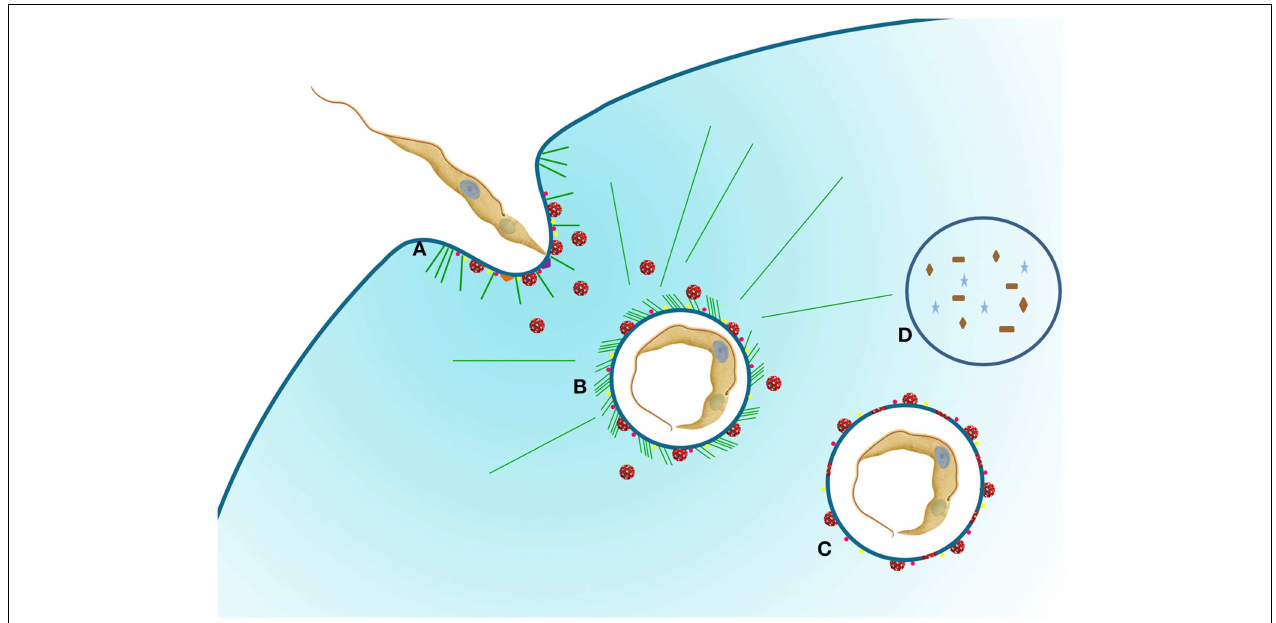
macropinocytosis pathway. (B) With the vacuole formed, lysosomes are still recruited to the PV promoting acidification and labeling with PAK1 and rabankyrin 5 are also present. At this time the parasite can survive and continue the life cycle (C) or be degraded (D) . Actin filaments (green lines) can be observed. We used T. cruzi as an example of protozoa that can use